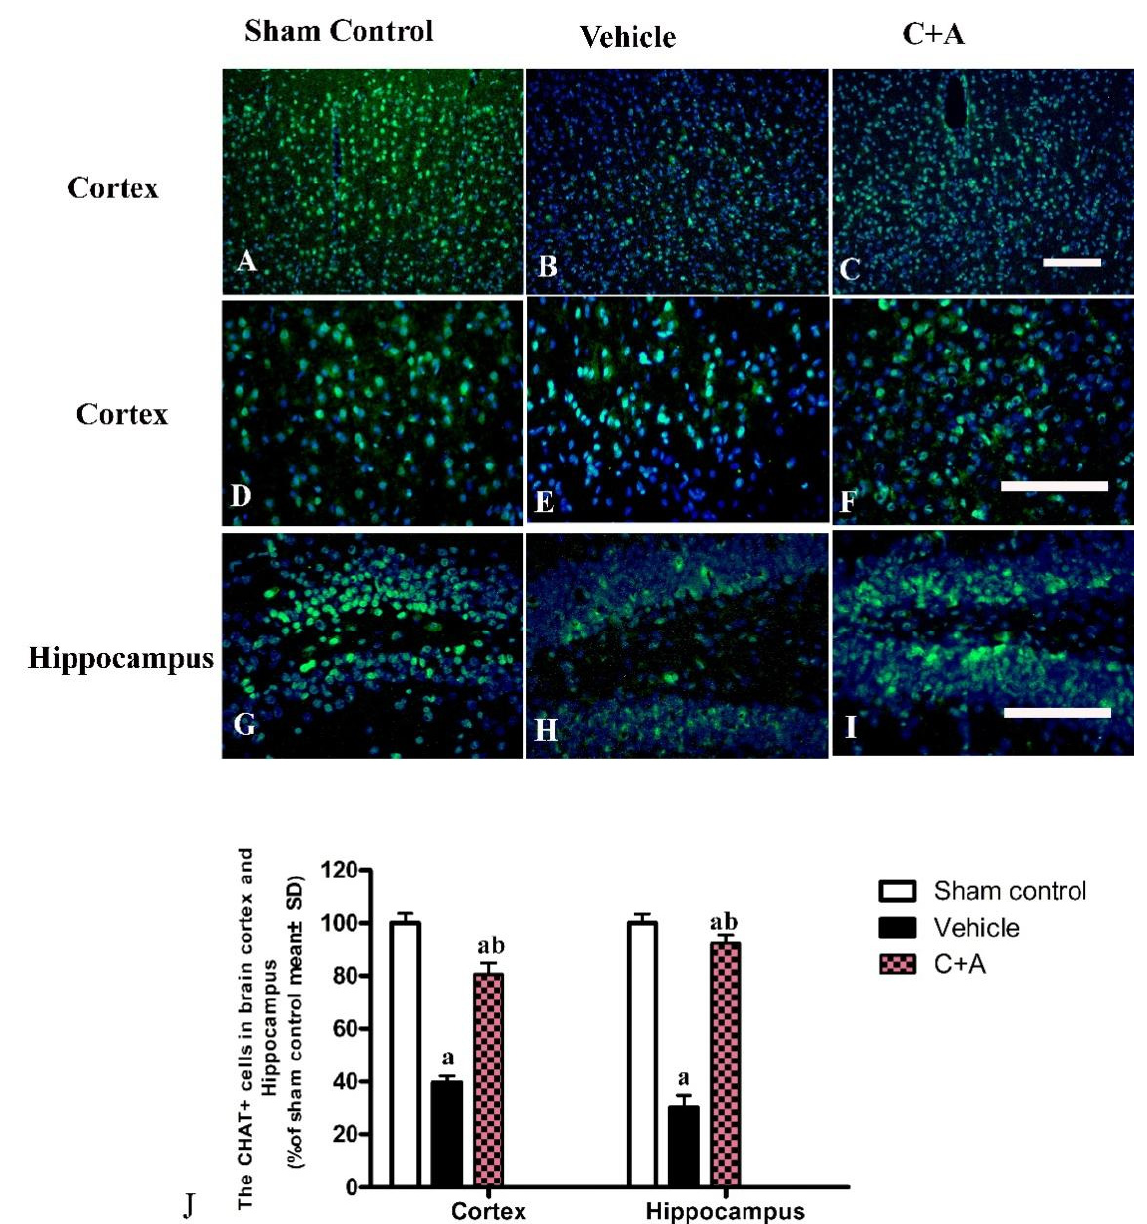
Figure 10. ( A – I ): Immunofluorescence staining (green) of CHAT in the motor cortex ( A – F ) and hippocampus ( G – I ). The nuclei of neurons in the cortex and hippocampus were visualized by Hoechst 33342 staining (blue). ( J ): Quantification of CHAT-positive cells indicated that treatment with C16 plus Ang-1 induced the expression of CHAT in AD rats. Scale bar = 100 µm. a, p < 0.05 vs. sham control group; b, p < 0.05 vs. vehicle group.